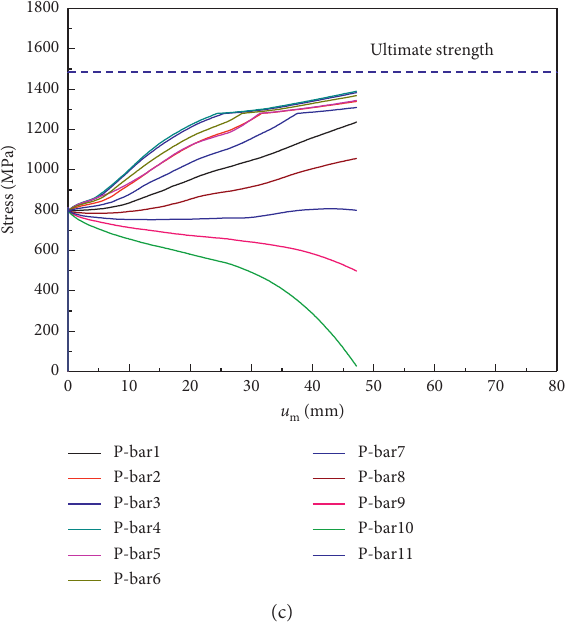
Figure 24: Stress-displacement curves of CT-10. (a) Anchor bar. (b) Deformed bar. (c) Prestressed